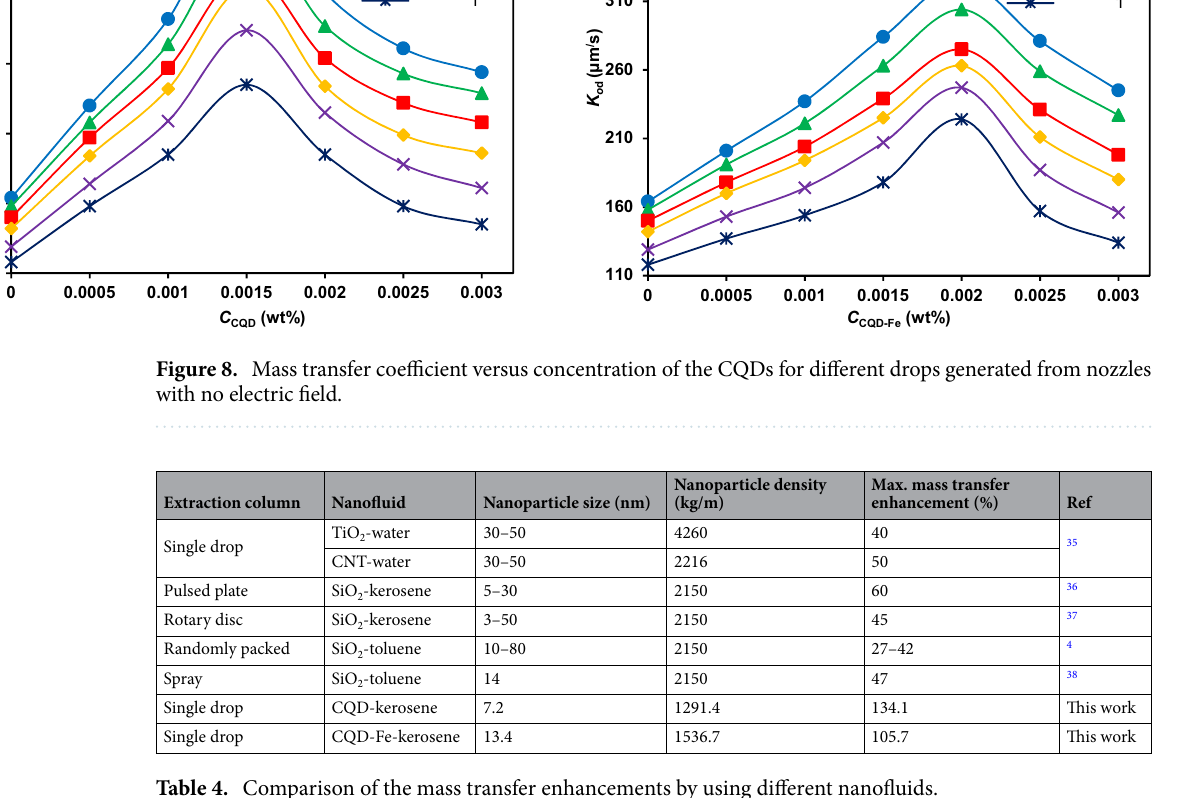
Table 4. Comparison of the mass transfer enhancements by using different